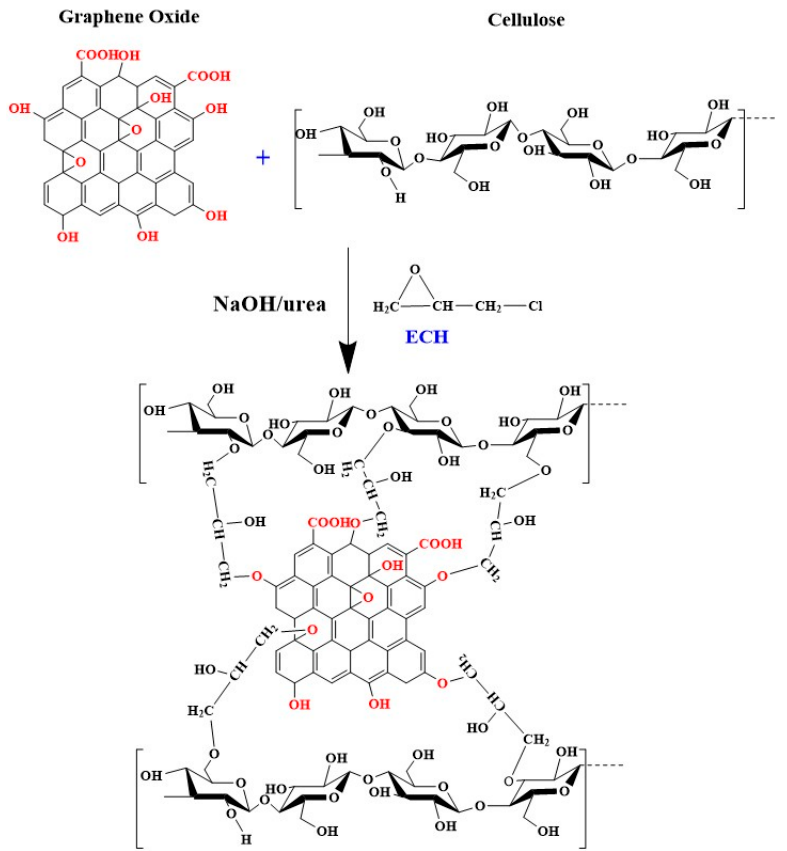
Figure 3. Proposed mechanism for cross-linking reaction of ECH with GO and cellulose.